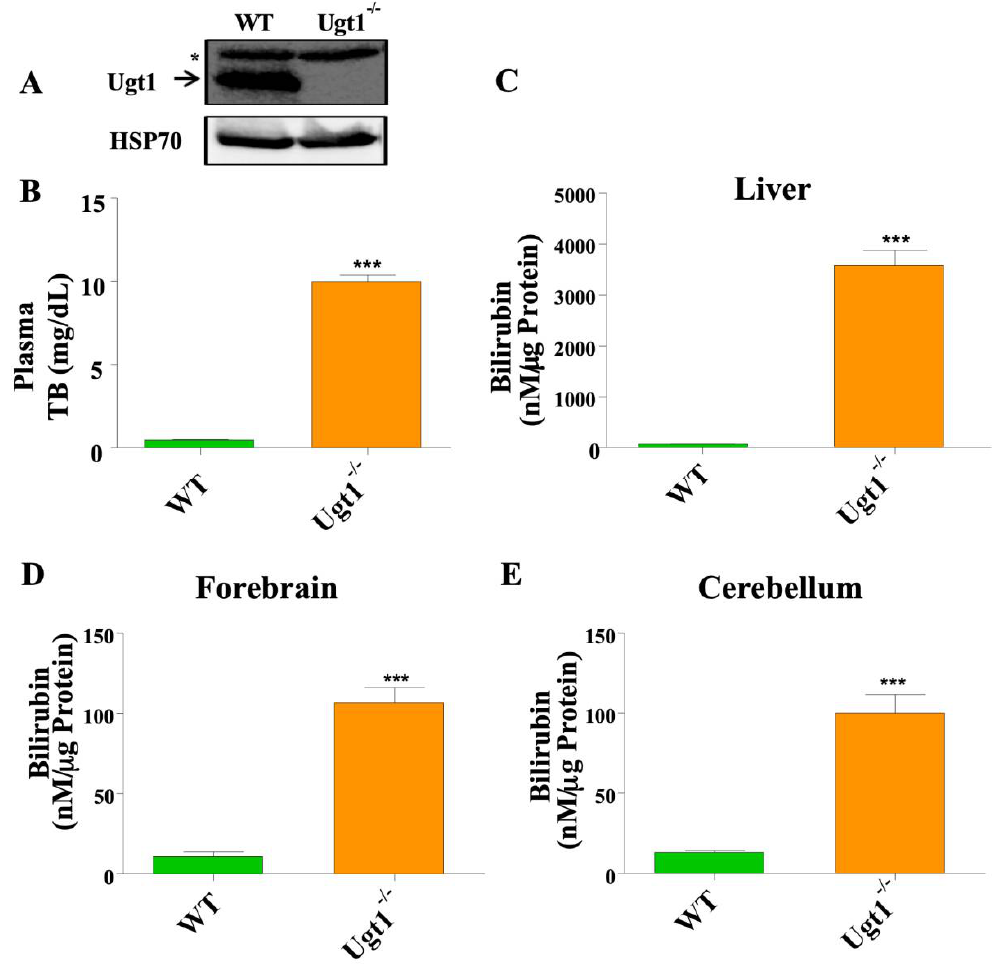
Figure 1. Adult Ugt1 −/− animals have an upregulated level of blood and tissue bilirubin. ( A ) Western blot analysis for Ugt1a1 expression in the liver of WT and Ugt1 −/− adult mice. Hsp70 was used as the loading control. ( B ) Plasma total bilirubin level (mg/dL) in WT ( n = 5) and Ugt1 −/− ( n = 5) adult mice. Tissue bilirubin level (nM/μg Protein) in ( C ) Liver ( D ) Forebrain and ( E ) Cerebellum in WT ( n = 3) and Ugt1 −/− ( n = 3 for each treatment group) adult mice. Values represent mean ± SD. t -test was performed and *** p < 0.001 were interpreted as statistically significant. The asterisk in Panel ( A ) indicates an unspecific